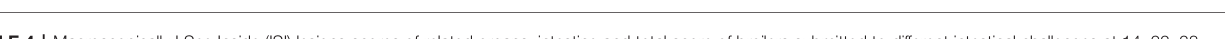
TABLE 4 | Macroscopically I See Inside (ISI) lesions scores of related organs, intestine and total score of broilers submitted to different intestinal challenges at 14, 22, 28 and 36 days of age. The broilers challenged with DSS received 0.25mg/ml (25DSS) or 0.35mg/ml (35DSS) of DSS via oral gavage everyday from 9 to 14-d and 23 to 27-d; birds in the NSP treatment received a diet with 30% of rice bran during the whole experiment, and animals in the control group were not submitted to any challenge.